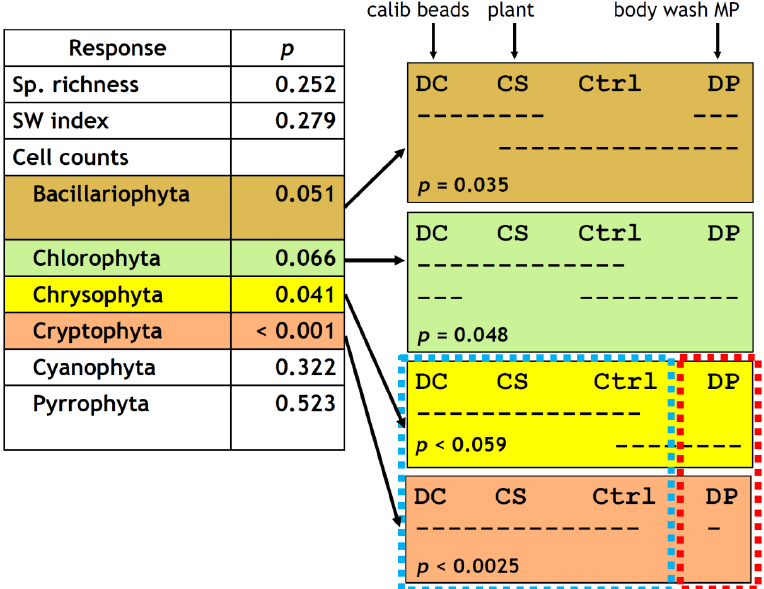
Figure 6. Summary of one-way ANOVA ( left ) and grouping by Tukey’s HSD test ( right ) on the taxonomic responses of the phytoplankton to the treatments. n = 4 for all four treatment groups except for chl. a for DC (n = 3 due to sample loss). Dashed horizontal lines in the right panel indicate Tukey’s HSD groupings; for example, for Bacillariophyta (top right box), DC, CS, and DP formed one group and CS, Ctrl (control), and DP formed another group. While an overlap existed between the two groups, DC and Ctrl never belonged to the same group and therefore had statistically different responses in this case ( p = 0.035 for the DC–Ctrl contrast). Similarly, CS–DP contrast for Chlorophyta was significant ( p = 0.048), DP–DC and DP–CS contrasts had p < 0.059, and DP–DC, DP–CS, and DP–Ctrl contrasts had p < 0.0025.